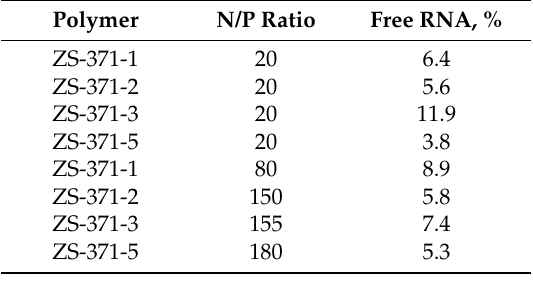
Figure 3. Gel electrophoresis data for AKX-371-N (N = 1, 2, 3, 5) complexes with DNA. “0”–free DNA (similar blots were observed irrespective of DNA length). DNA concentration was 2.5 µM (calculating on DNA chains). Table 4. Interaction of si-RNA with LCPA containing polymers.